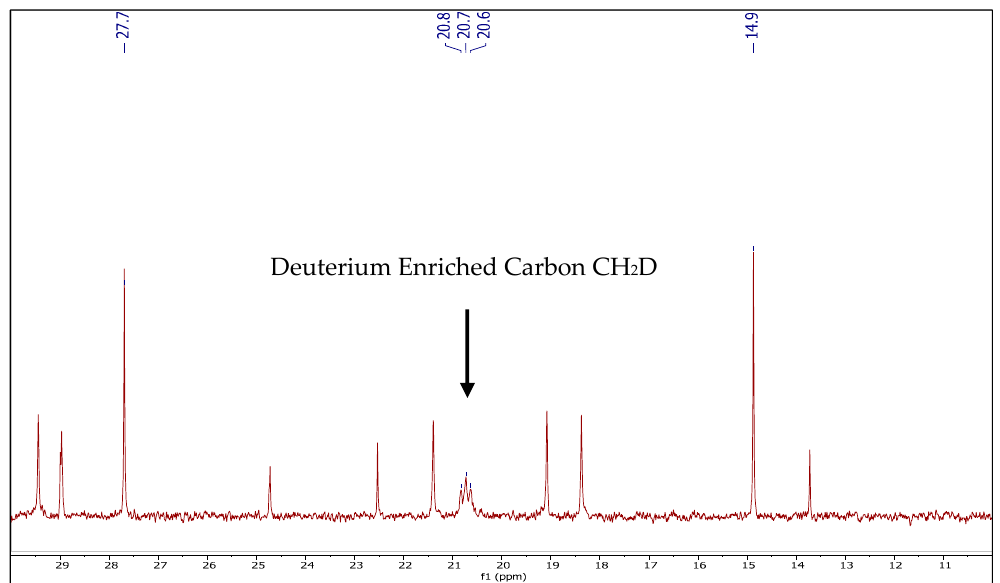
Figure 3. 13 C NMR analysis of deuterated rebaudioside A degradation compound 2d highlighting triplet on C17.